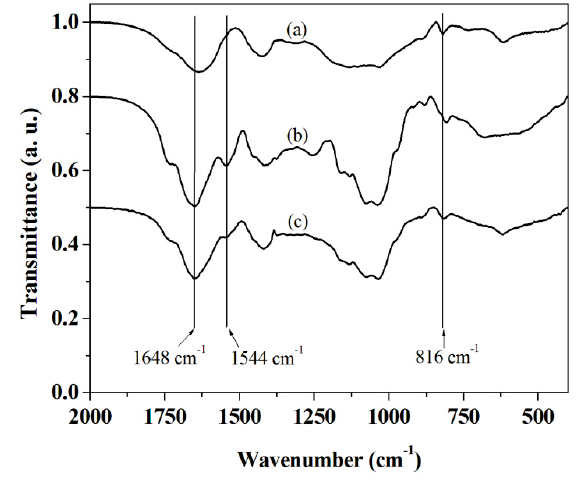
Figure 1. FTIR spectra of copper alginate beads ( a ), laccase ( b ) and copper alginate beads loaded with laccase ( c